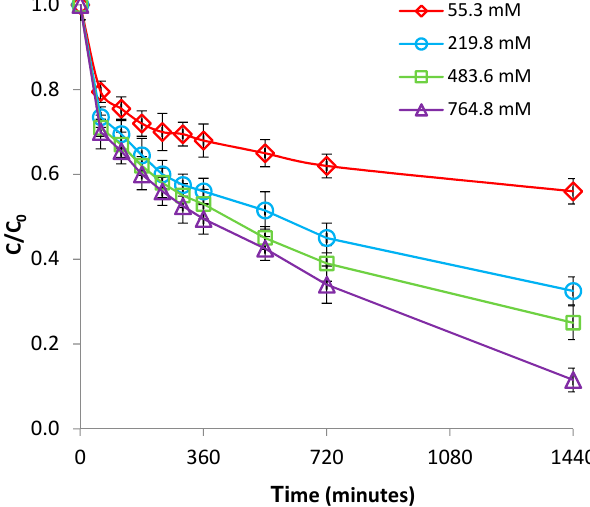
Figure 11. Effect of ionic strength on Cr(VI) removal by Be-Fe(0).